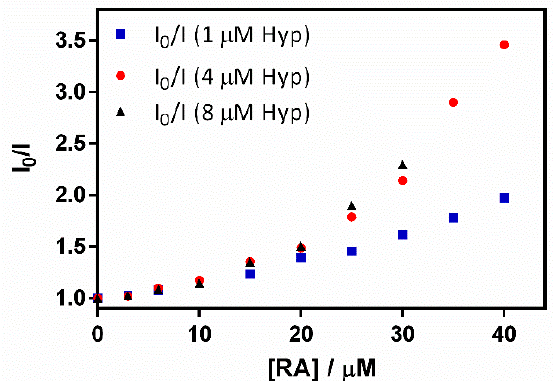
Figure 10. A Stern–Volmer plot for the quenching of the hypericin (Hyp) fluorescence–retinoic acid (RA)– β -lactoglobulin ( β LG) complex (fixing β LG concentration at 60 µ M) with different Hyp concentrations (1, 4, and 8 µ M) upon the addition of increasing RA concentrations.